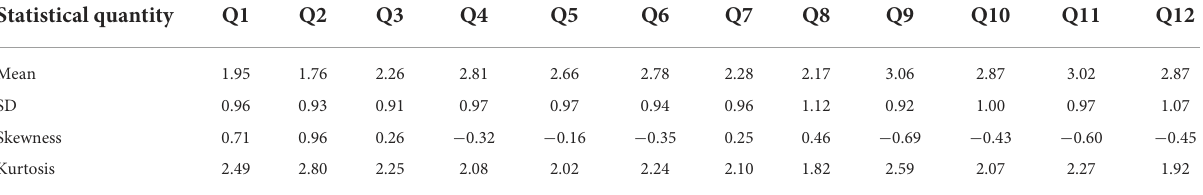
TABLE 3 Basic statistical quantities of the responses for each question